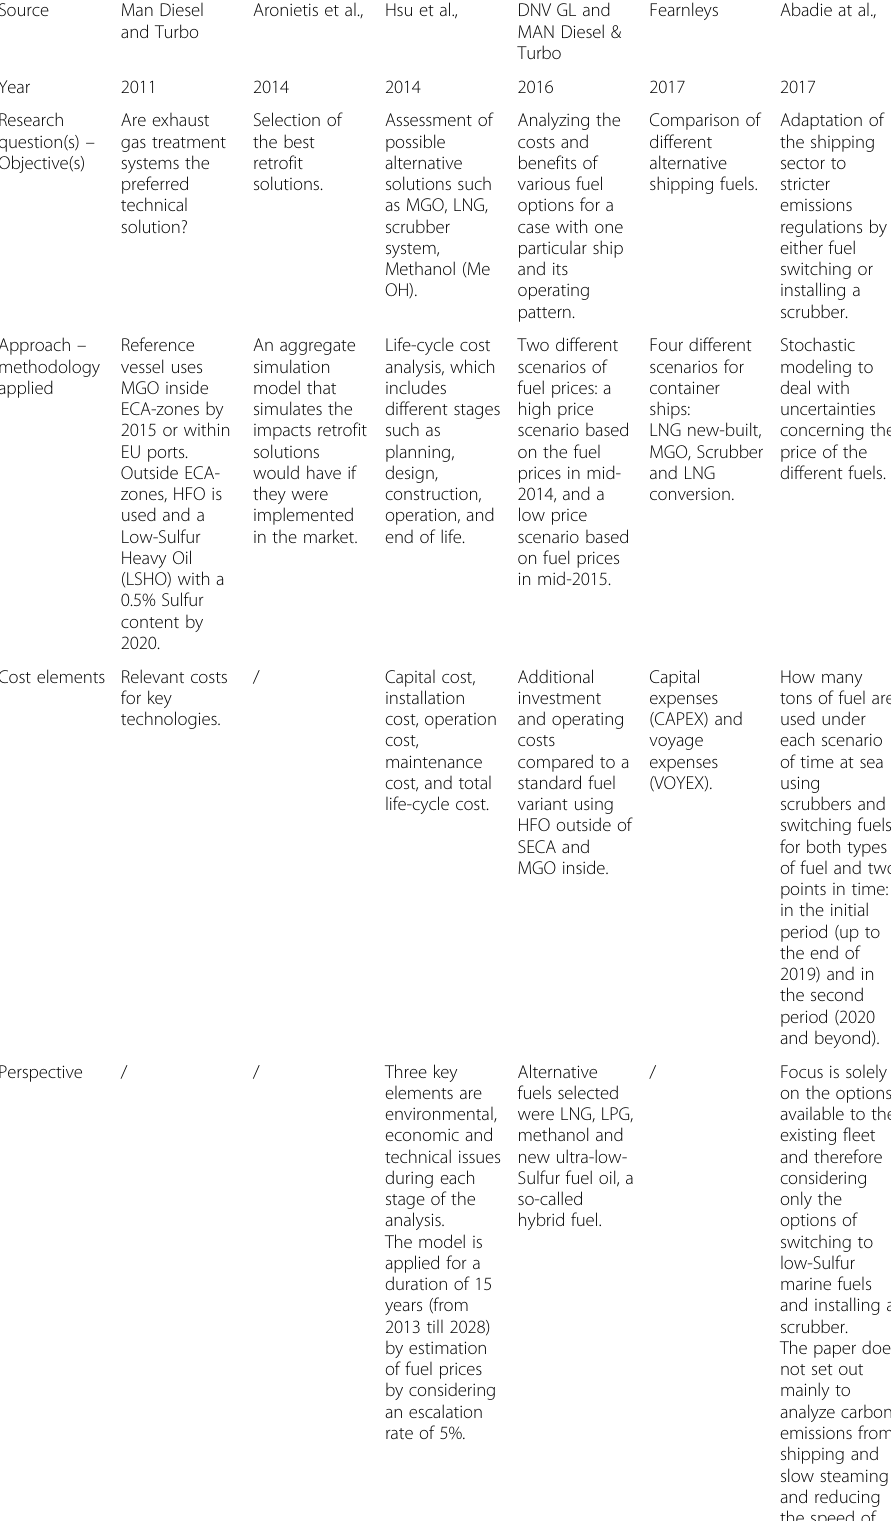
Table 6 Researches on alternative